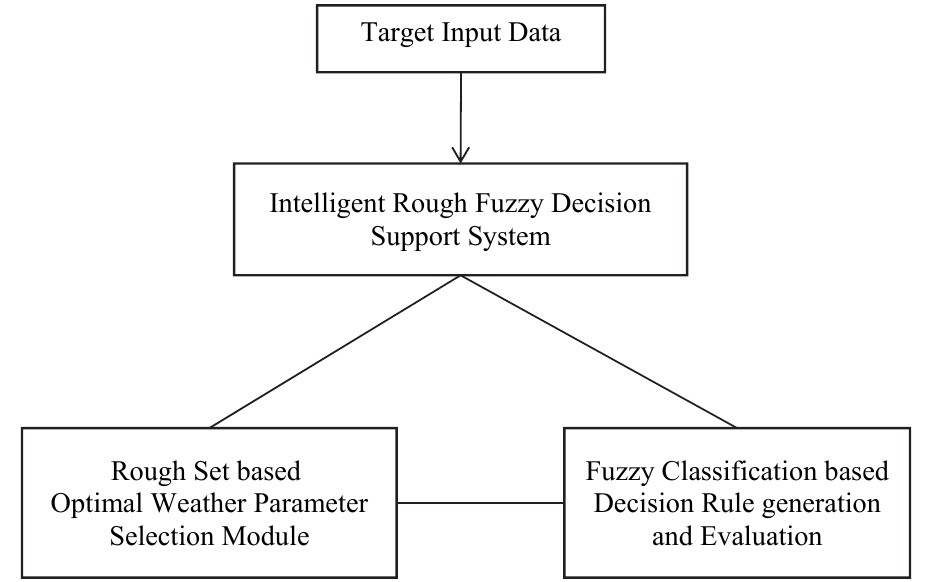
Fig. 1. Intelligent Rough Fuzzy Rainfall Prediction